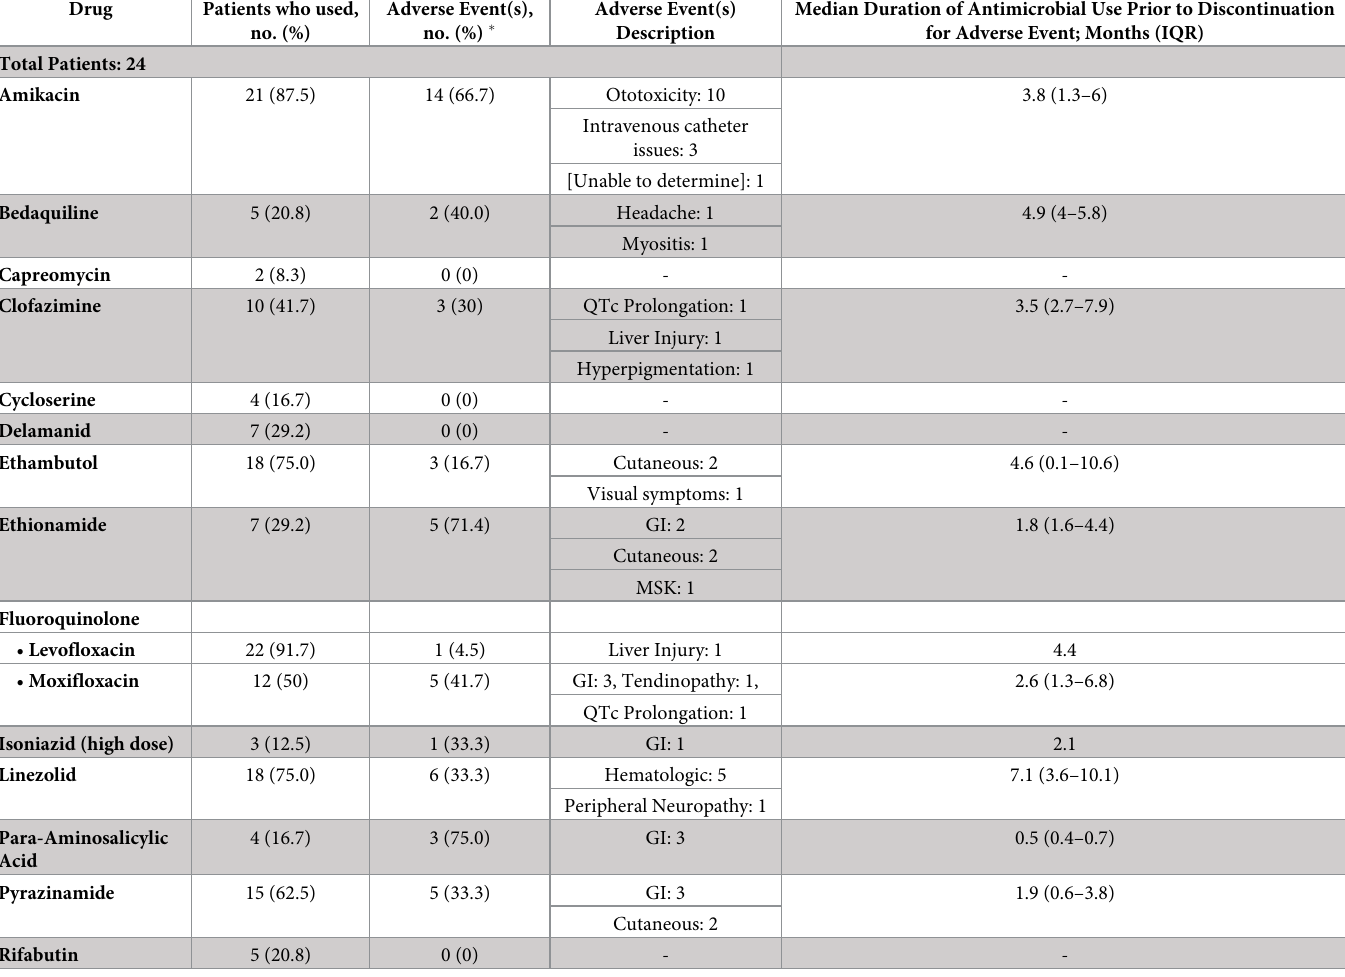
Table 4. Medication adverse events. Drug Patients who used, no.